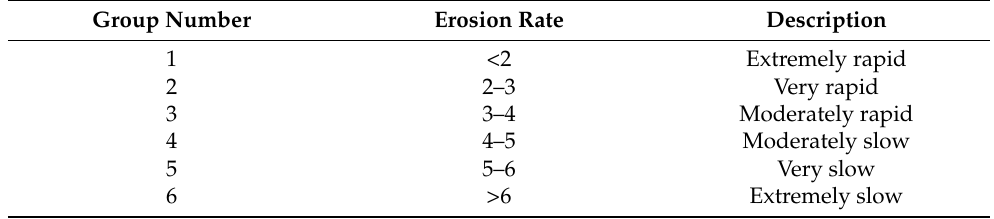
Table 3. Descriptions of internal soil erosion for representative erosion rate index [10]. Group